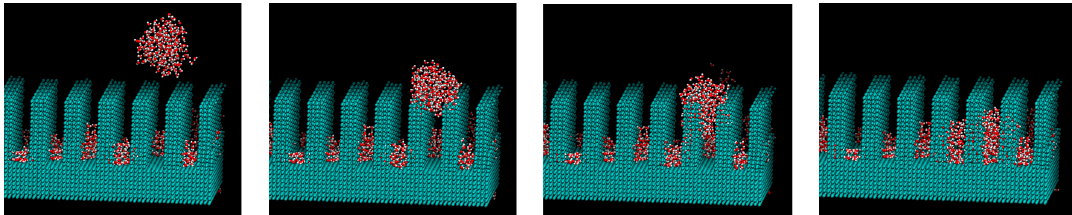
Figure 12. Absorption behavior of water droplets intruding into the inside of asperities with ε = 1.976 kJ/mol. (0 s, 35 ps, 90 ps, 350 ps).